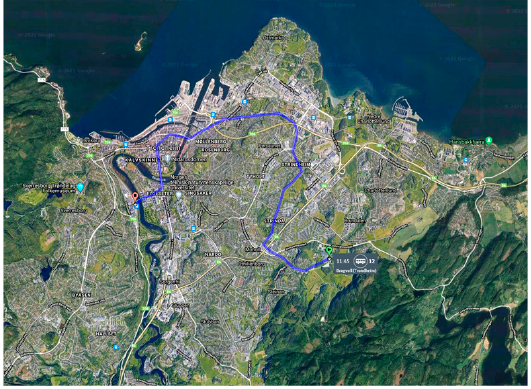
Figure 4. Line 12 Trondheim (Norway).